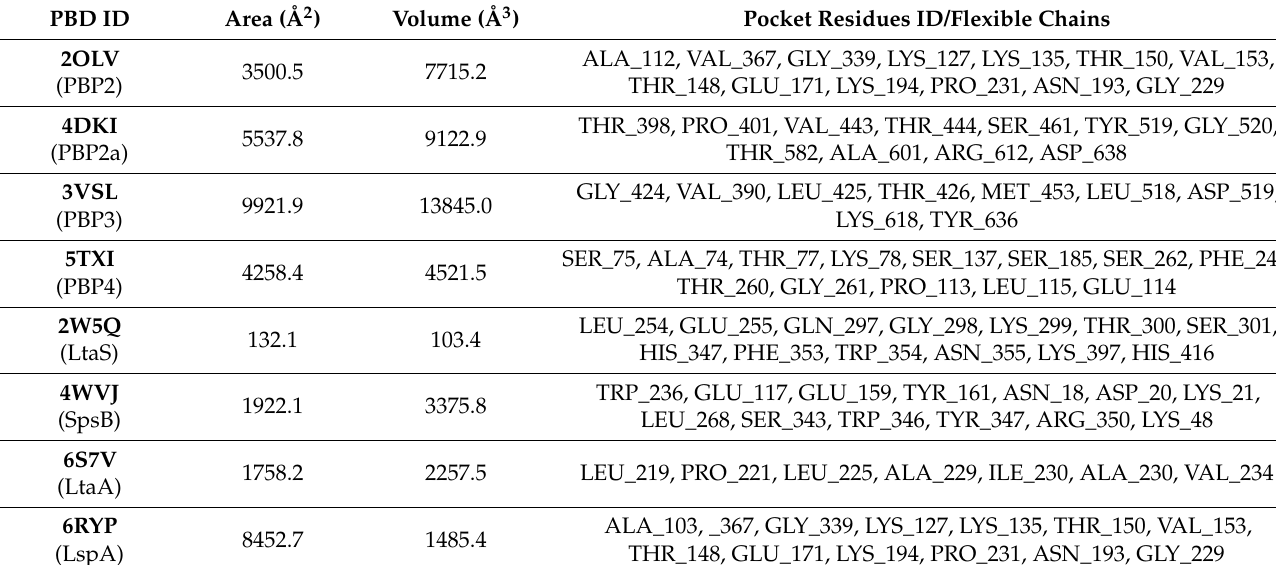
Table 3. Predicted binding